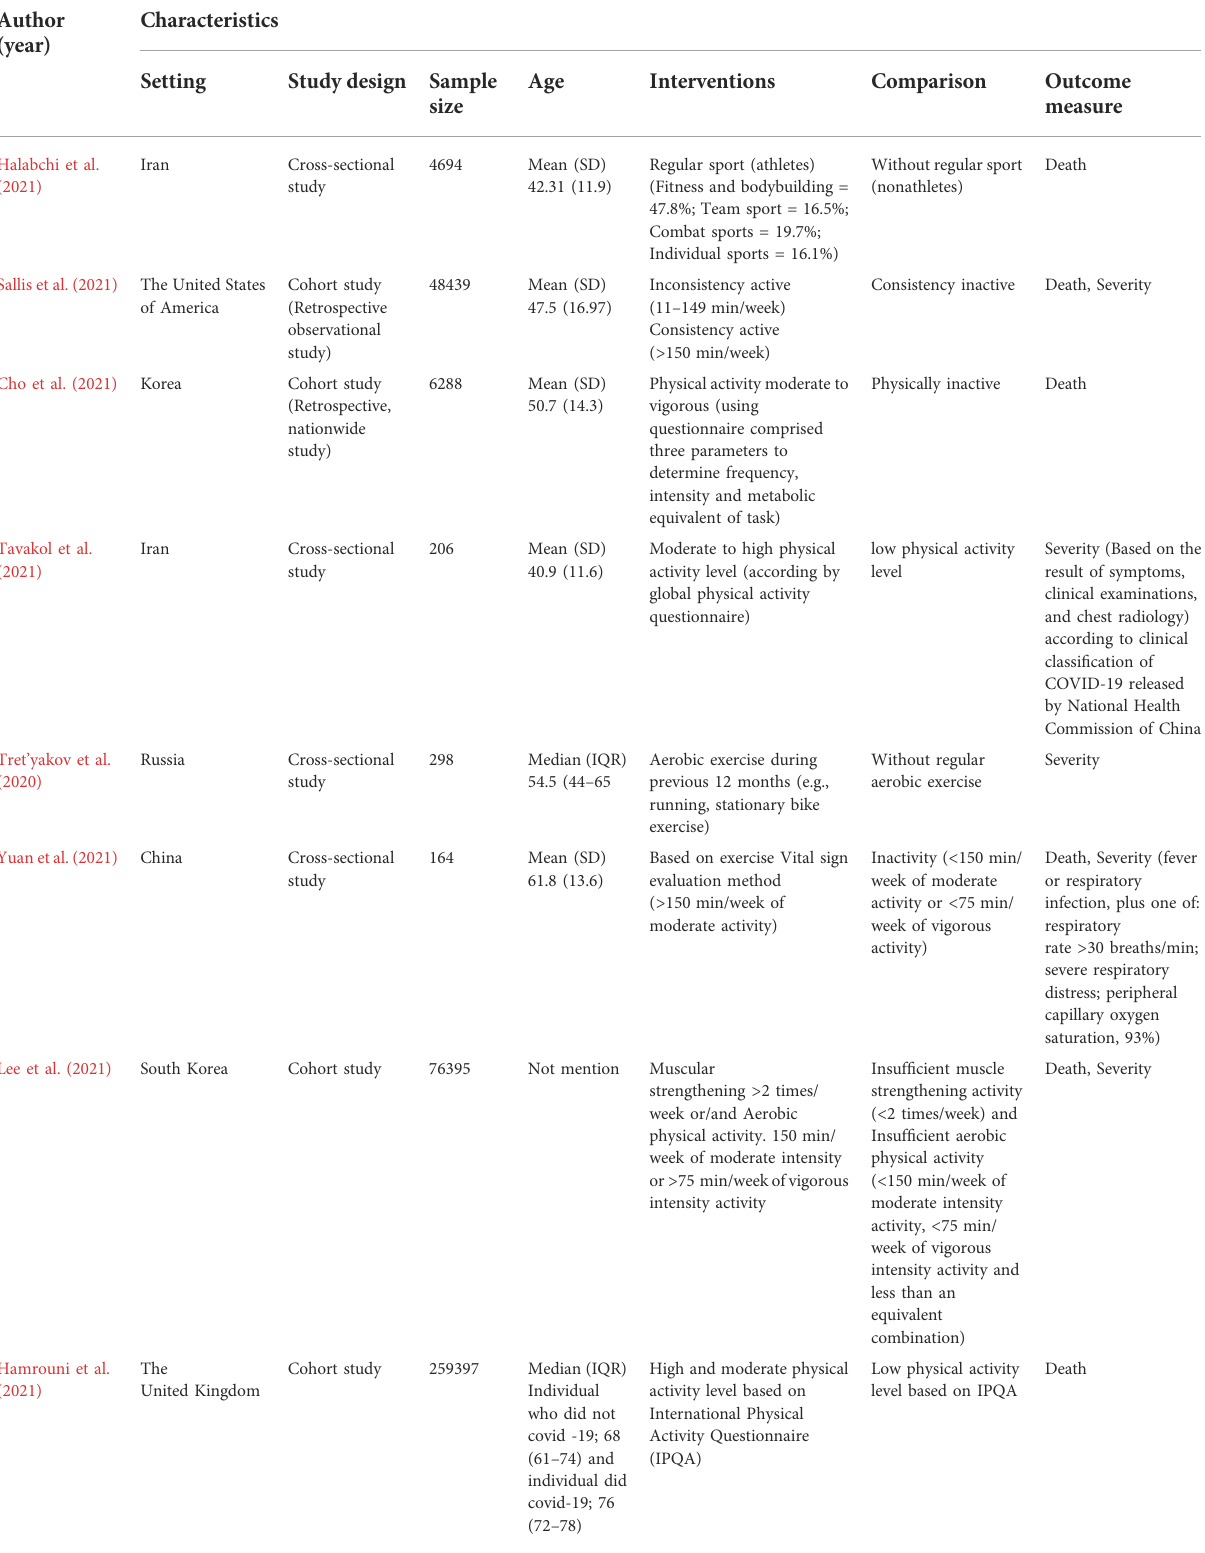
TABLE 1 Characteristics of the included